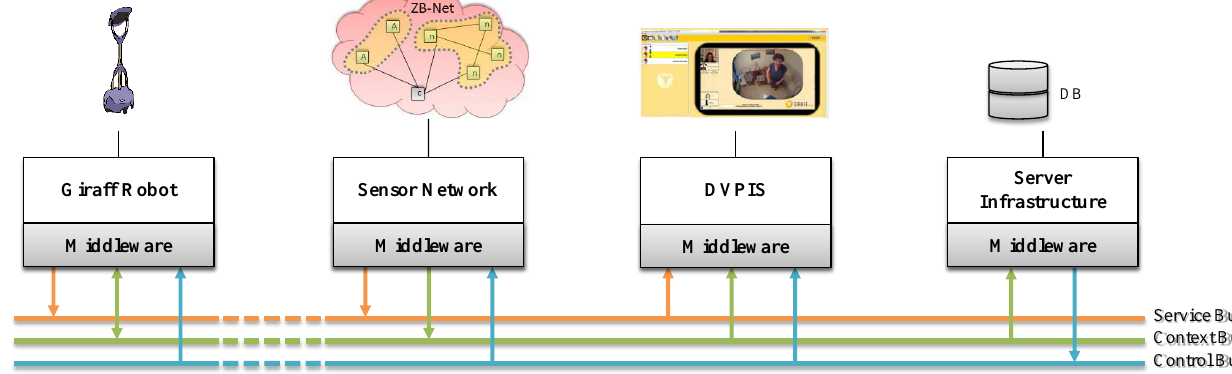
Figure 4. Interaction between components and buses. DVPIS, data visualization, personalization and interaction